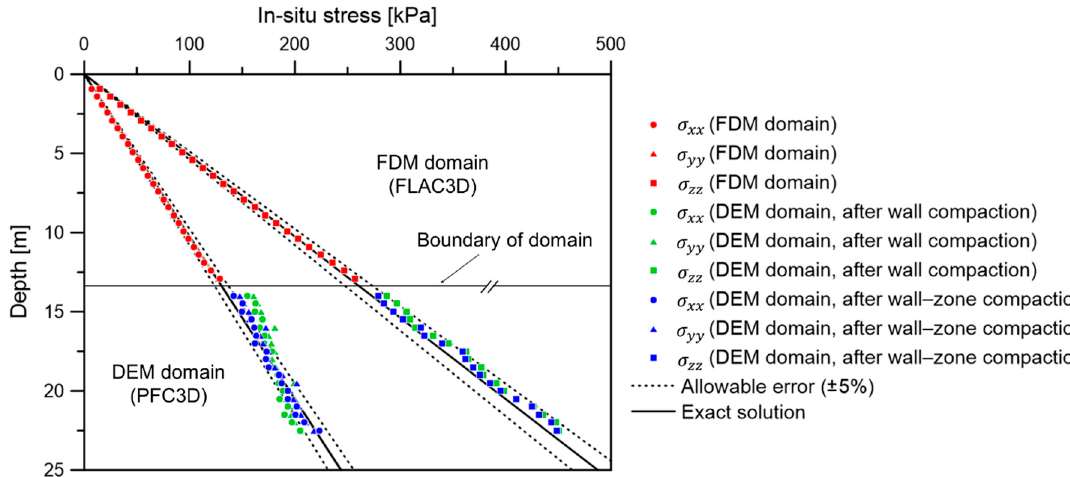
Figure 7. Vertical and horizontal in situ stress distribution of coupled DEM-FDM ground formation.